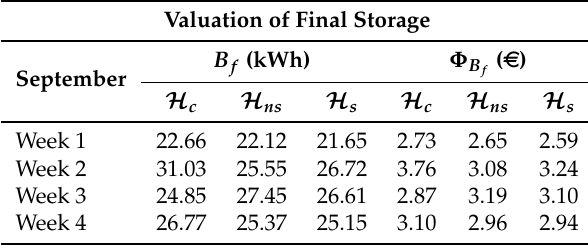
Table 9. Valuation of final stock of stored energy.